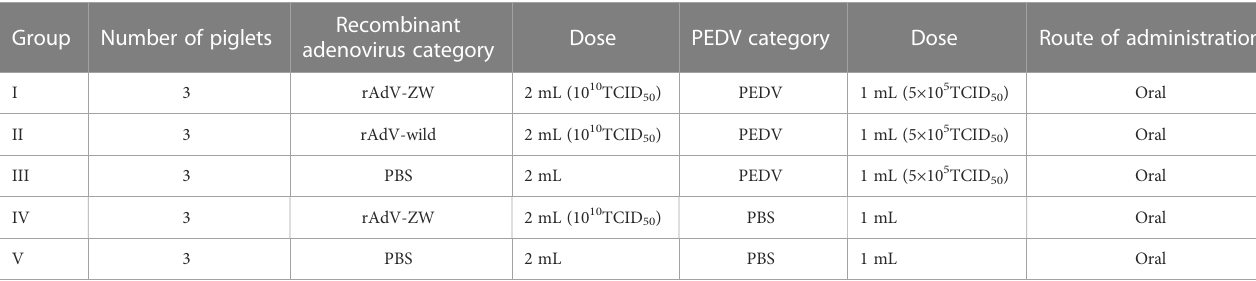
TABLE 2 PEDV challenge in piglets: experimental design.